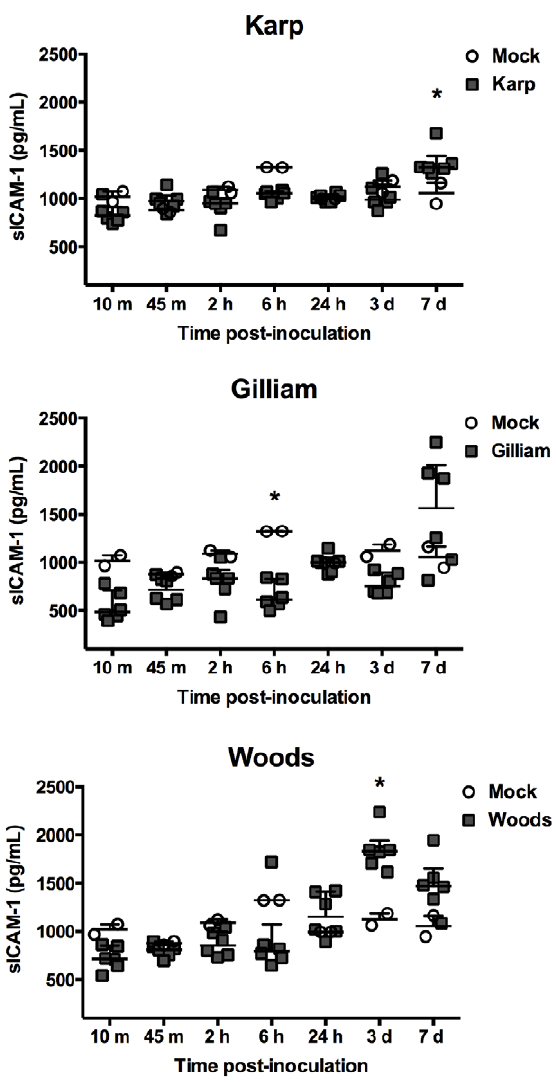
Figure 5. Serum levels of circulating soluble VCAM-1. Dot plots demonstratesVCAM-1 levels in inoculated mouse sera. (Mock inocula- tion; n=2 per time point, O. tsutsugamushi inoculation; n=6 per time point). Bars indicate median and error bars represent interquartile range. The asterisks indicate significant differences ( P , 0.05).